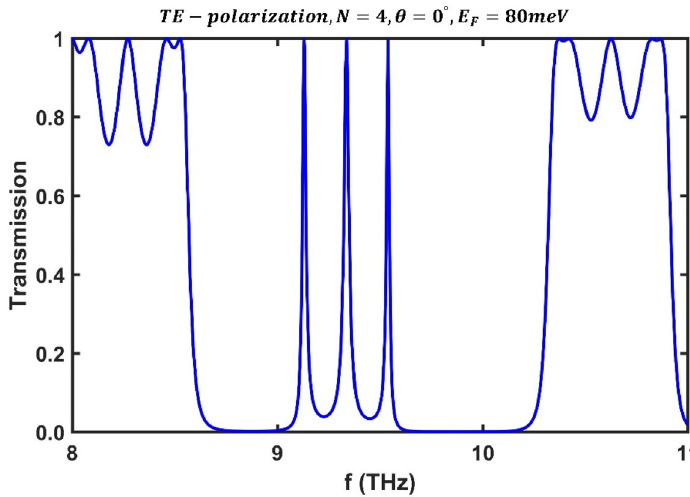
Figure 2. Transmission spectrum of the third-order F-1D PhC under normal incidence for TE polarization state corresponding to Fermi energy E F = 80 meV and period number N = 4 .